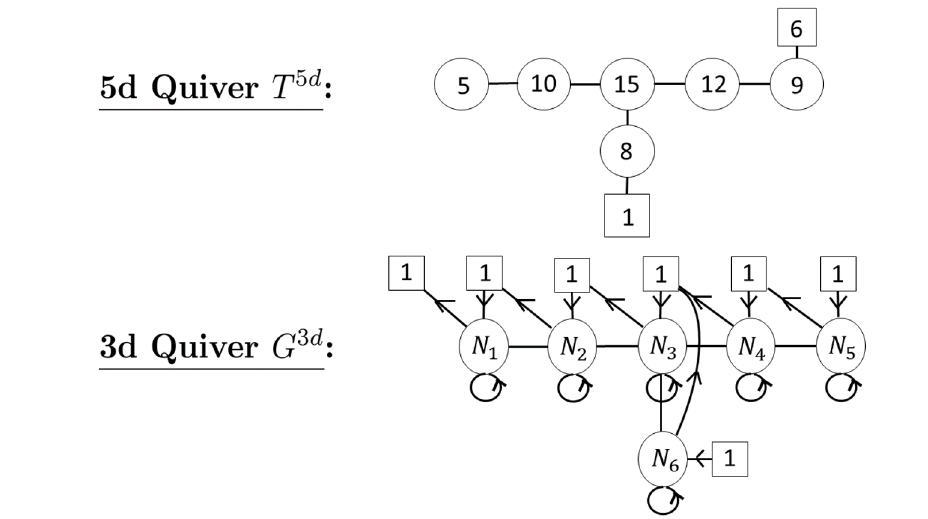
Figure 4. Sphere with 3 full E 6 punctures: 5d theory T 5d and 3d theory G 3d resulting from W S .